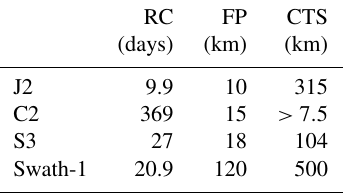
Table 2. Satellite altimetry mission characteristics (https://earth.esa. int/web/eoportal/satellite-missions, last access: 18 October 2018). The columns show the following altimeter orbit parameters: repeat cycle (RC; expressed as days), footprint (FP) and cross-track sepa- ration (CTS; expressed as km). The rows show the altimeters con- sidered in this study: Jason-2 (J2), CryoSat-2 (C2), Sentinel-3a (S3; Donlon et al., 2012) and Swath-1. In Swath-1, CTS is the distance of consecutive ocean cross-overs points given by the overlap of an ascending and a descending pass (Esteban Fernandez et al., 2014).